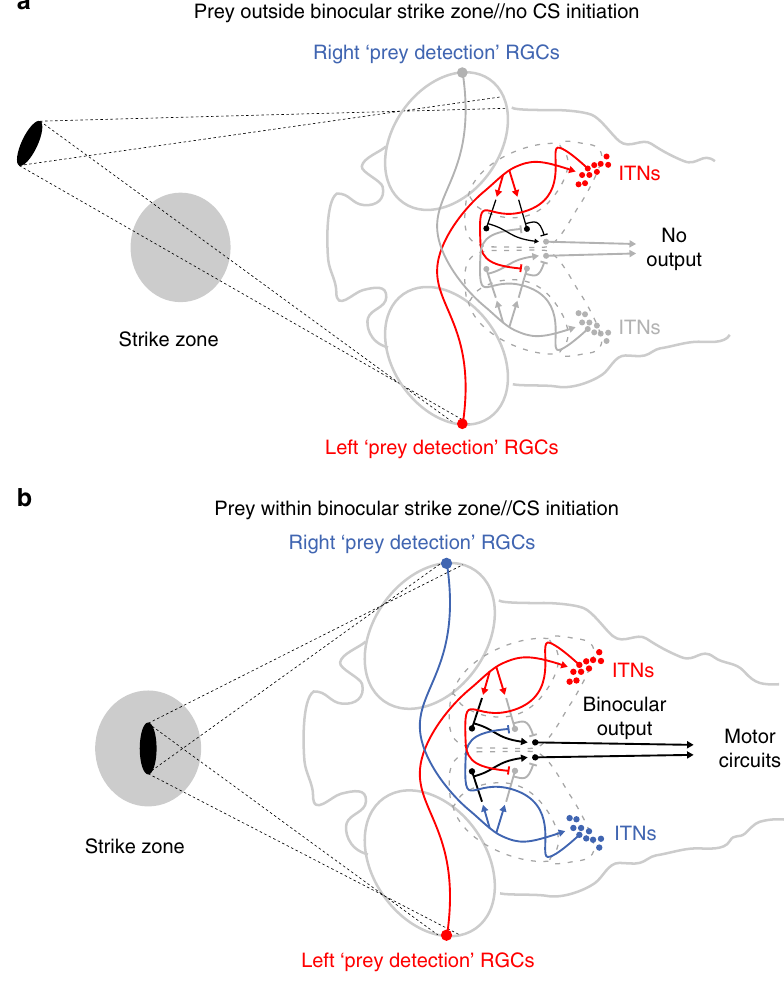
Fig. 6 Model circuit for the integration of binocular visual input to localize prey and initiate capture swims. a Prey located outside the strike zone will at most activate the trigger zone of just one eye. RGCs transmit visual information to the contralateral OT and contralateral ITNs. ITNs in turn cross the midline to convey visual information to the opposite OT. In this case, local inhibitory interneurons in the oppposite OT prevent a capture swim from being triggered. b When prey is positioned inside the binocular strike zone, both trigger zones are activated. Thus, each tectum receives direct contralateral retinal input, as well as indirect, ITN-mediated input carrying information from the ipsilateral eye. The coincidence of excitatory drive and disinhibition, respectively, allows a premotor command to be generated to initiate a capture